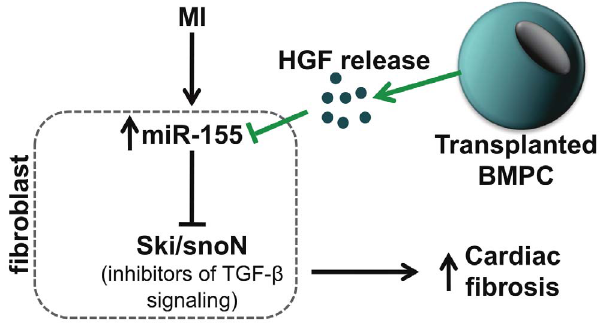
Figure 9. Proposed mechanisms of the paracrine regulation of cardiac fibrosis by transplanted BMPCs. BMPCs release HGF, which inhibits miR-155 leading to de-repression of inhibitors of TGF- b signaling, Ski/SnoN (possible targets of miR-155), thereby inhibiting cardiac fibrosis. HGF indicates hepatocyte growth factor; BMPC, bone marrow-derived progenitor cell. MI indicates myocardial infarction; BMPC, bone marrow-derived progenitor cell; HGF, hepatocyte growth factor; TGF- b , TGF-beta; Ski, Sloan-Kettering Institute proto-oncogene; SnoN, Ski-related novel gene, non-Alu-containing.